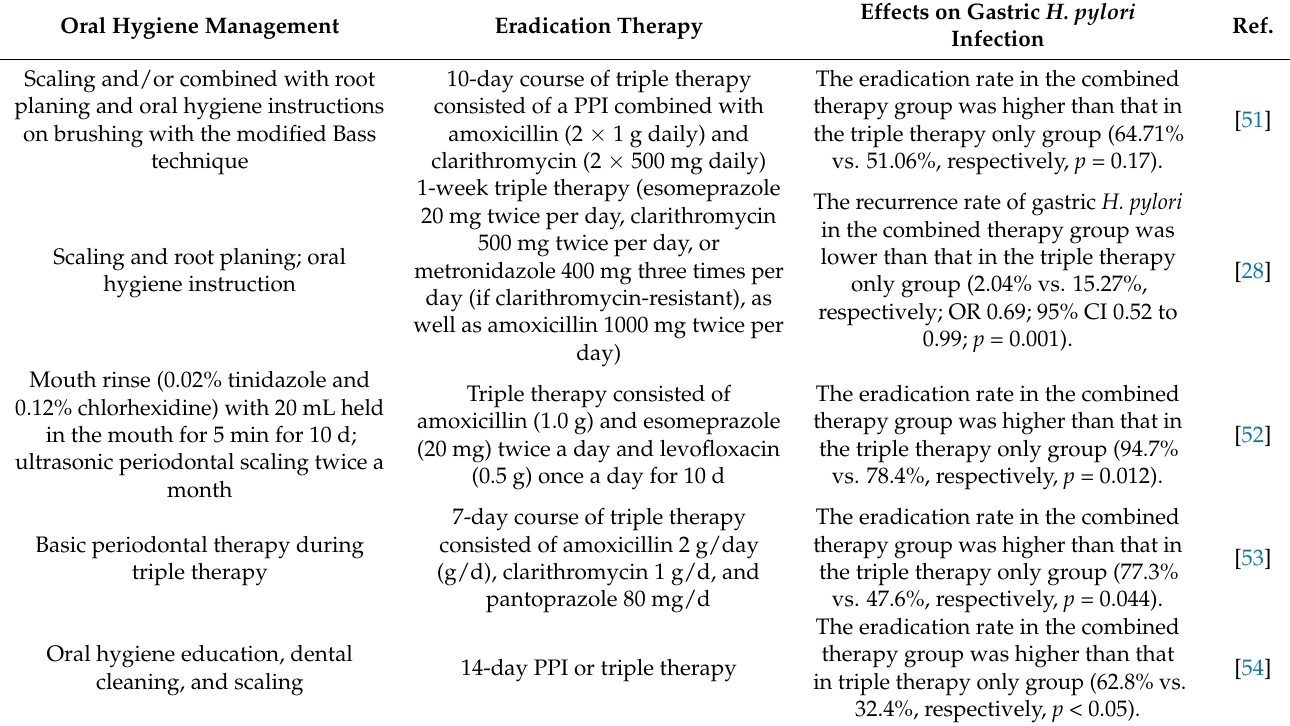
Table 2. Oral hygiene management strategies against H. pylori